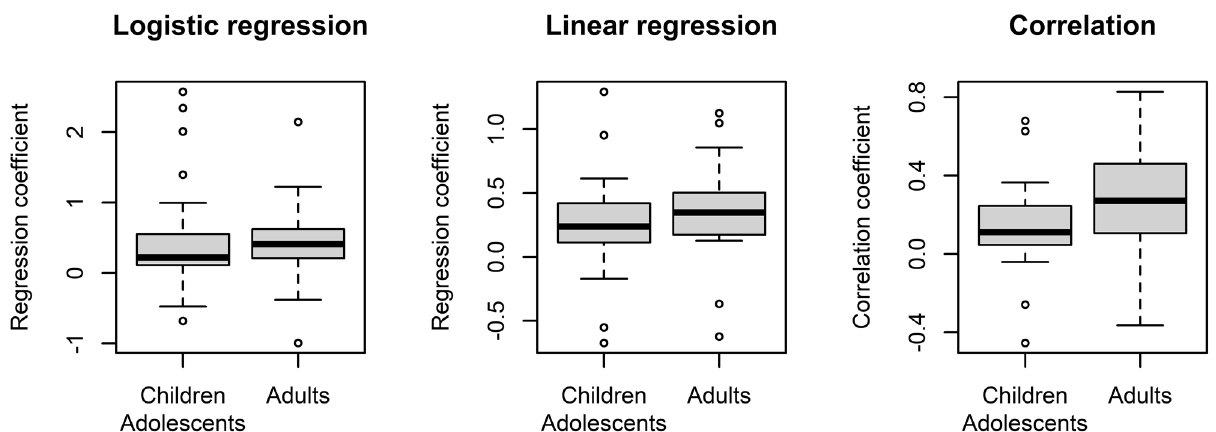
Figure 5. Comparison between age groups for measures of urge-tic association from the urge monitor. Boxes indicate inter-quartile range and median, whiskers extend to values up to 1.5 IQR beyond first and third quartile, respectively. Values outside this range are shown as individual